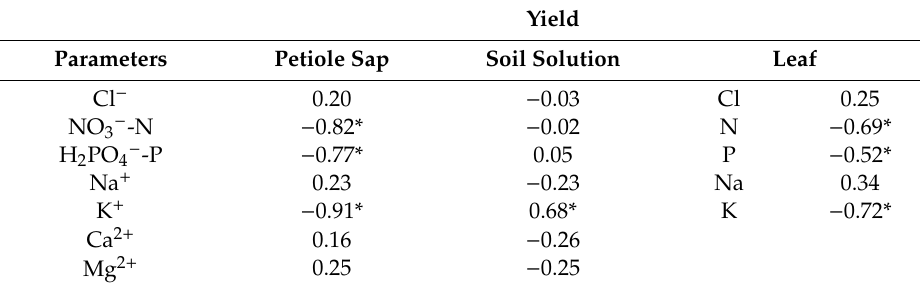
Table 6. Correlation coe ffi cients (r) between nutrient concentration in soil solution (Cl − , NO 3 − , H 2 PO 4 − , SO 42 − , K + , Na + , Ca 2 + , and Mg 2 + ) (mmol L − 1 ), petiole sap concentration (Cl − , NO 3 − - N, H 2 PO 4 − -P, SO 42 − -S, K + , Na + , Ca 2 + , and Mg 2 + ) (mg L − 1 ), and leaf nutrient concentration (N, P, K, Na, and Cl (mg g − 1 DW)) with tomato yield.